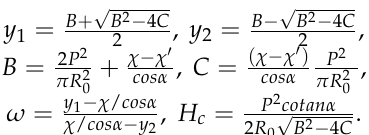
Table 1. Parameters used in Figure 4.